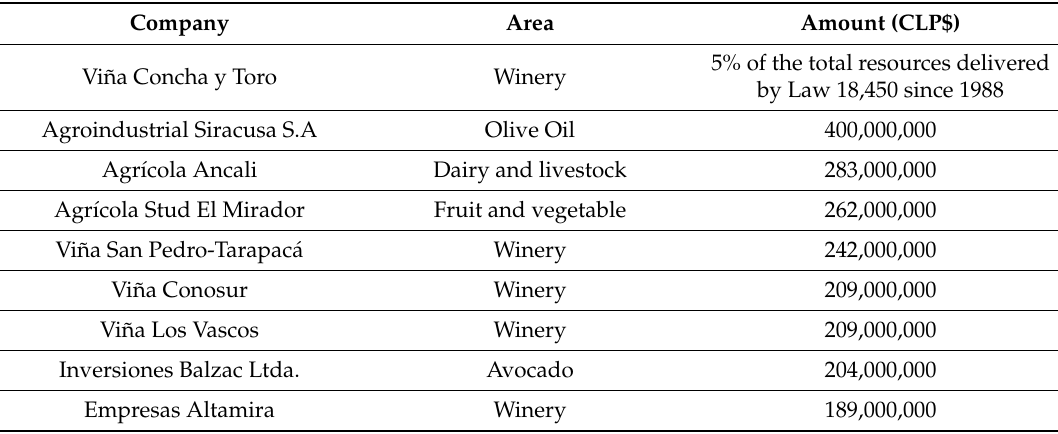
Table 4. Main companies benefited by Law